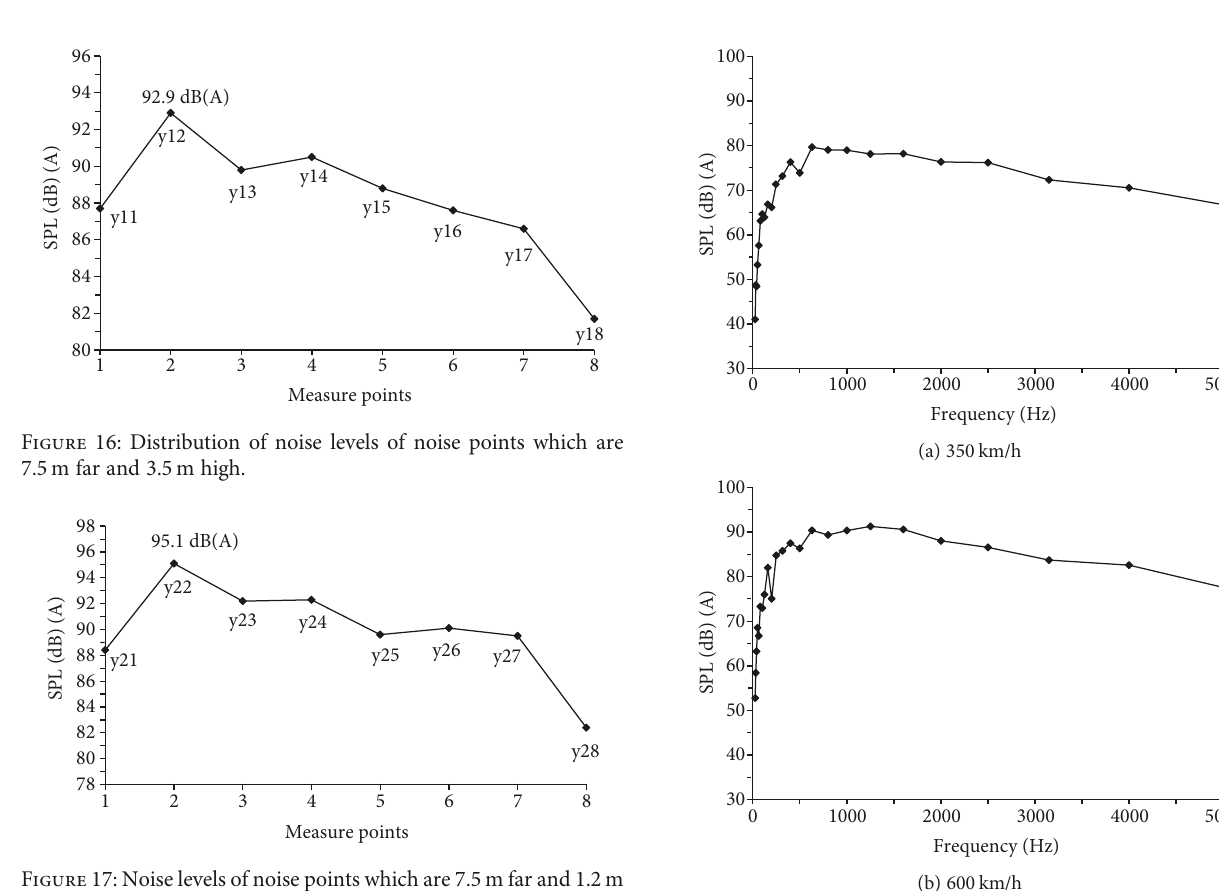
Figure 17: Noise levels of noise points which are 7.5m far and 1.2m high.